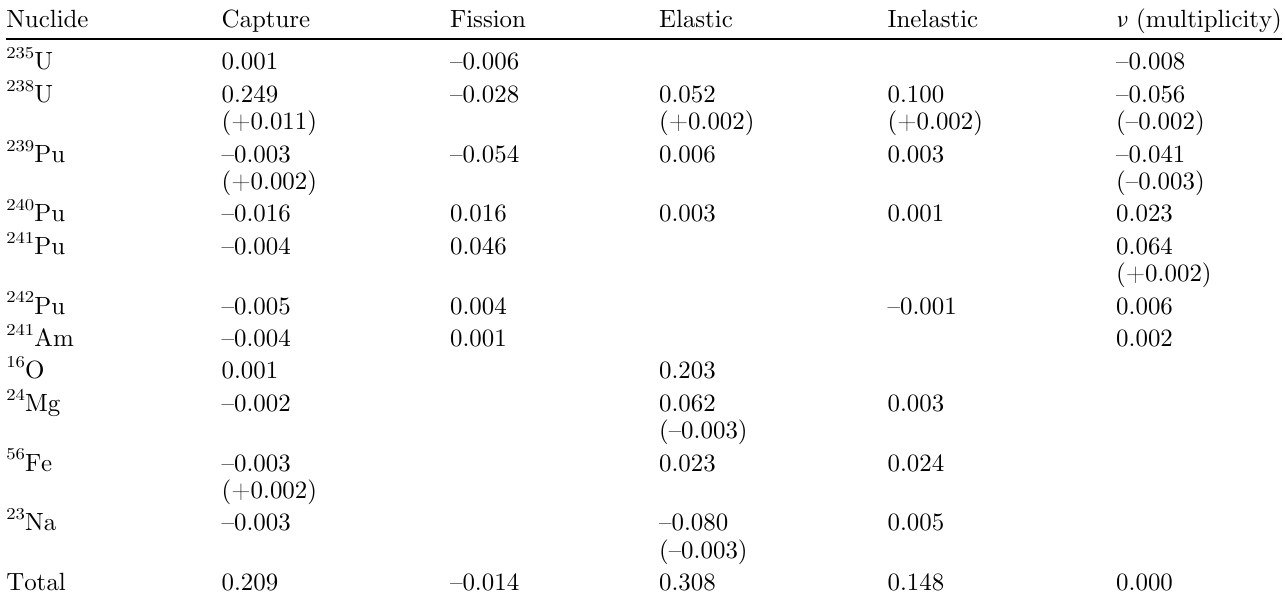
Table 8. Sensitivity of R i for position B: reference GPT values obtained by the continuous description and, between brackets, the absolute discrepancy (when it exceeds 0.001) with the sensitivity predicted using the discrete description with 384 meshes.